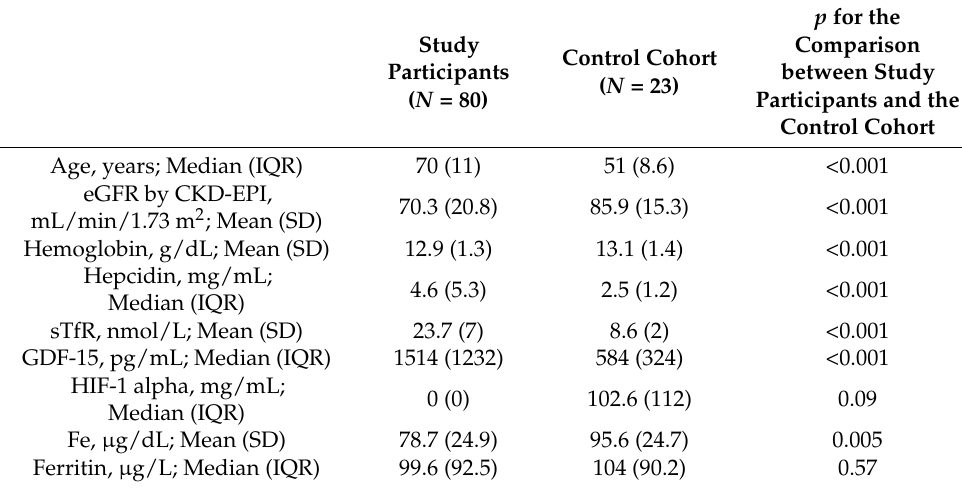
Table 1. Characteristics of the studied and control populations.